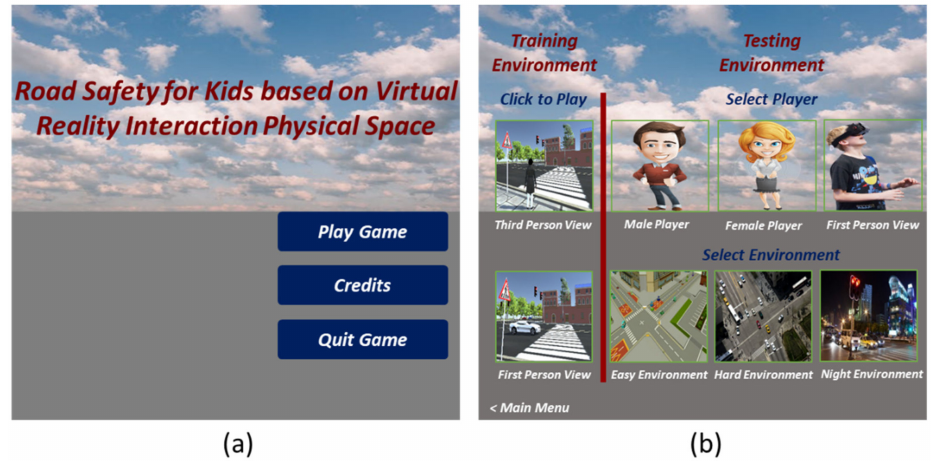
Figure 4. The interface of the VRBTS, where ( a ) represents main menu, while ( b ) shows the players and environments selection menu.